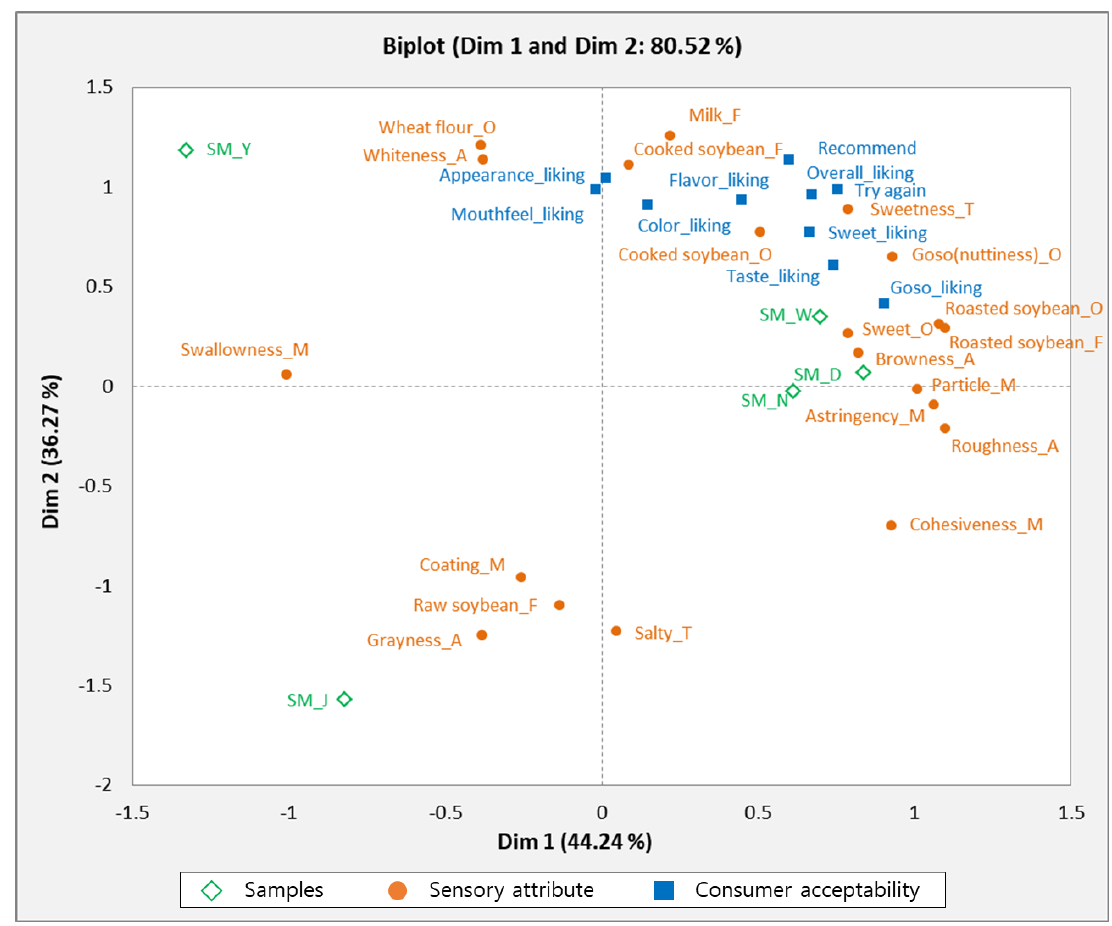
Figure 3. PLSR result from relationship between sensory attributes of five soymilks and consumer acceptability .